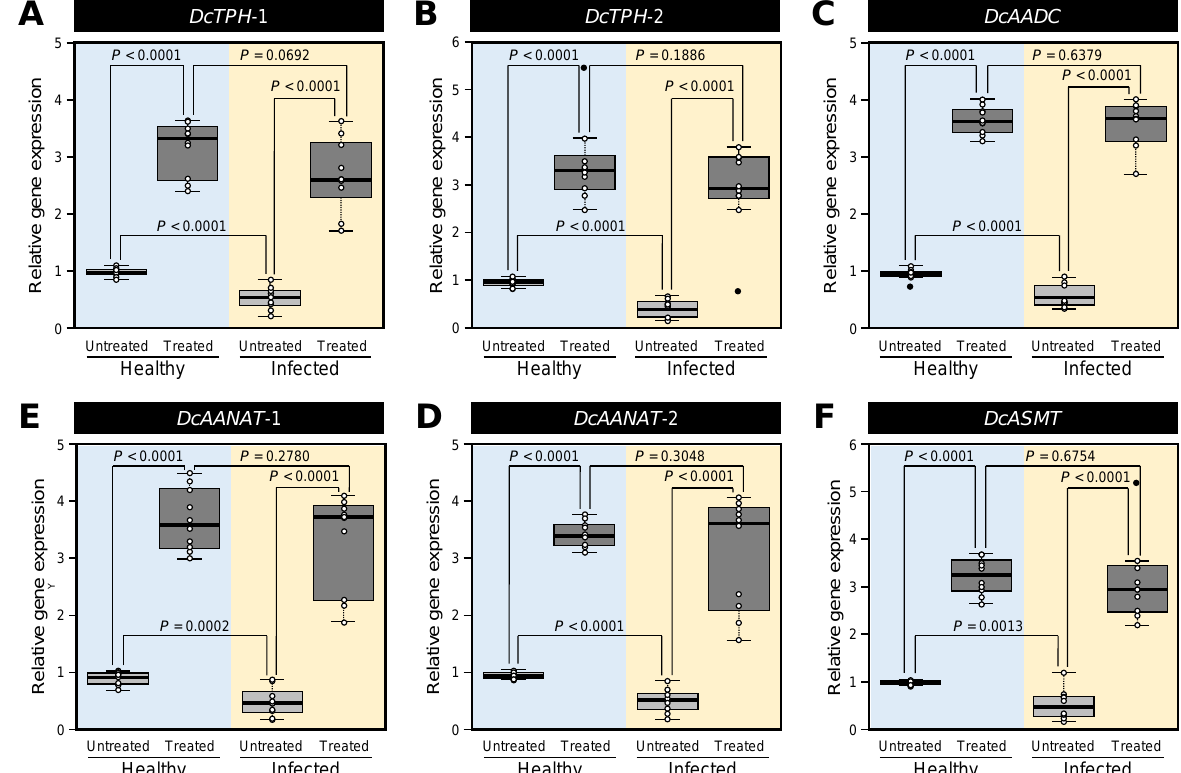
Figure 15. Effect of supplementation on the expression levels of melatonin biosynthesis-related genes of healthy and Ca. L. asiaticus-infected psyllids, Diaphorina citri . ( A , B ) Relative gene expression of tryptophan 5-hydroxylase ( DcT5H -1 and DcT5H -2, respectively), ( C ) relative gene expression of aromatic amino acid decarboxylase ( DcAADC ), ( D , E ) relative gene expression of arylalkylamine N-acetyltransferase genes ( DcAANAT -1 and DcAANAT -2, respectively), and ( F ) relative gene expression of N -acetylserotonin O-methyltransferase ( DcASMT ). Gene expressions were normalized using two housekeeping genes ( α -tubulin and actin), and the changes were analyzed using the 2 − ∆∆ C T method. Open dots indicate the raw data ( n = 10), the black ones indicate potential outliers, whereas horizontal thick lines indicate the medians. Whiskers indicate the minimum, and the maximum values of the data and boxes show the interquartile ranges (twenty-fifth to the seventy-fifth percentile of the data). Treatments (healthy versus infected and untreated versus treated) were compared using a two-tailed t -test, and statistical significance was established as p < 0.05. The full list of expressed genes, names, accession numbers, and primers are available in Table 1.